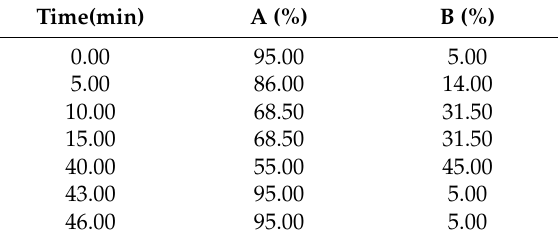
Table 6. The gradient